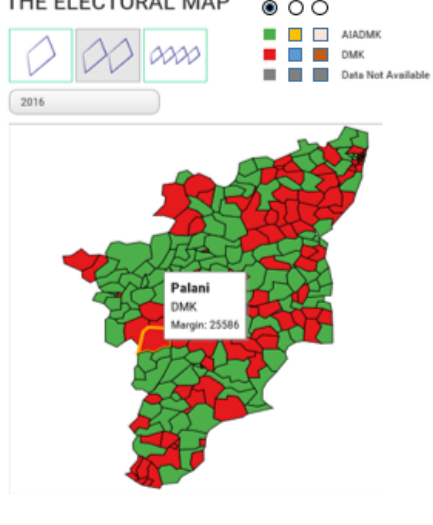
Figure 17: Providing User Choice for Changing Color Scheme on